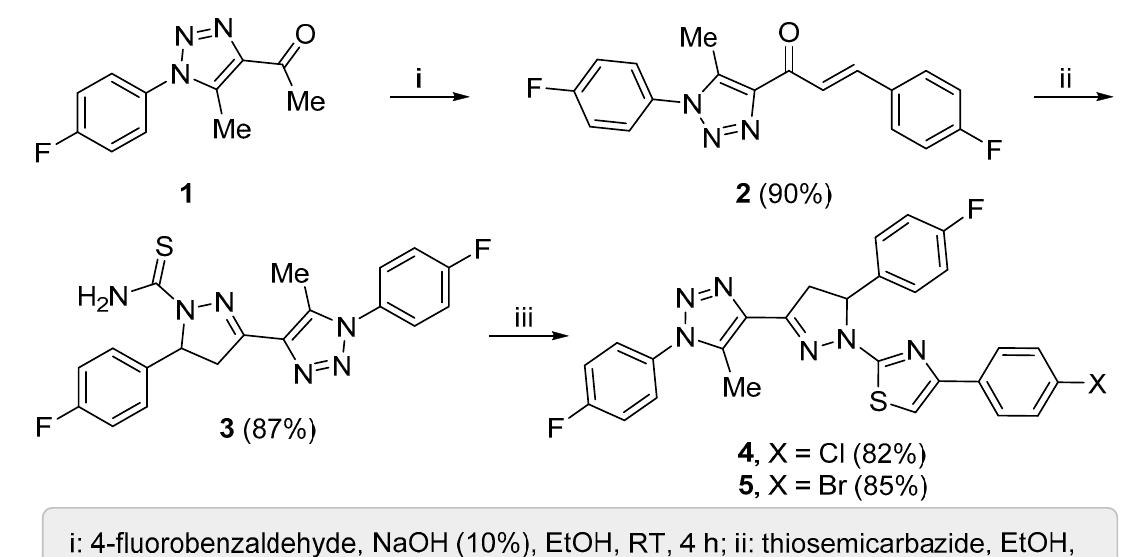
Scheme 1. Synthesis of 4 and 5 .